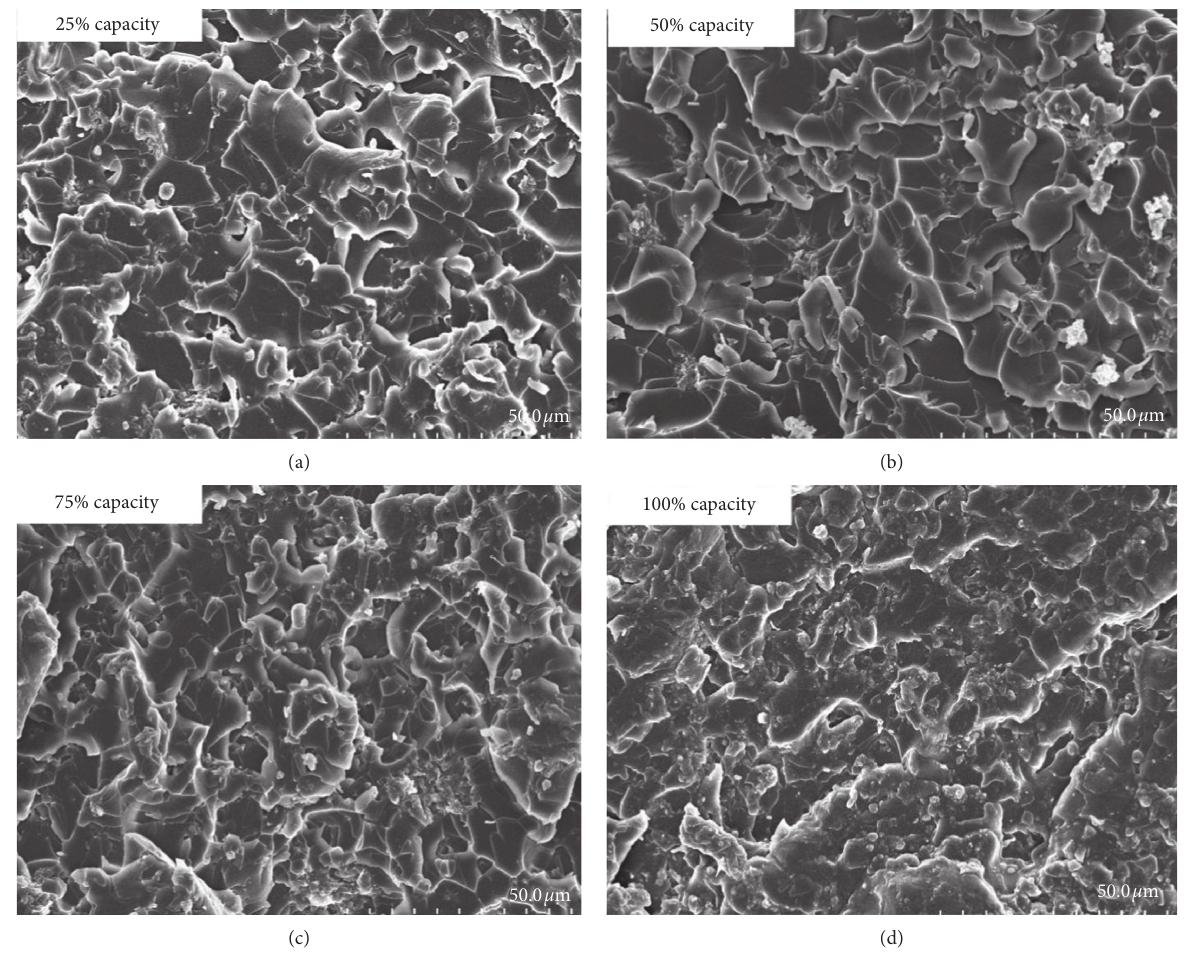
Figure 9: FE-SEM image of epoxy Epikote 240/nanoclay I.30E nanocomposite materials with various ultrasonic stirring capacities: 25W, 50W, 75 W, and